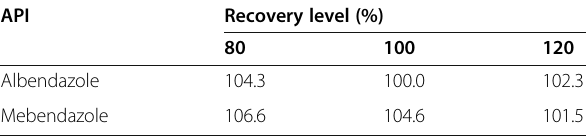
Table 2 Recovery at 80, 100, and 120% of the working concentration